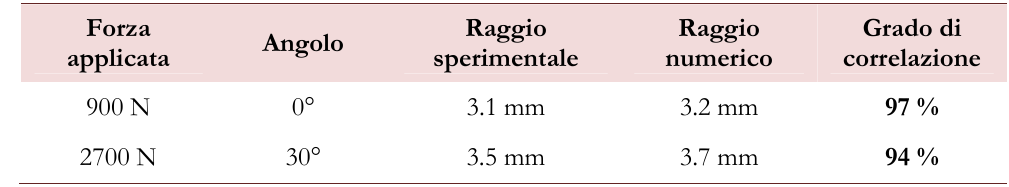
Table 2: Correlation between the experimental and numerical results for the two loading